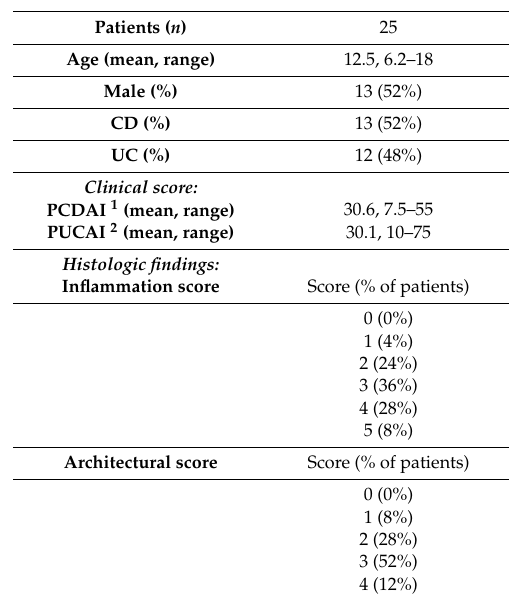
Table 1. Characteristics and histologic scores of the